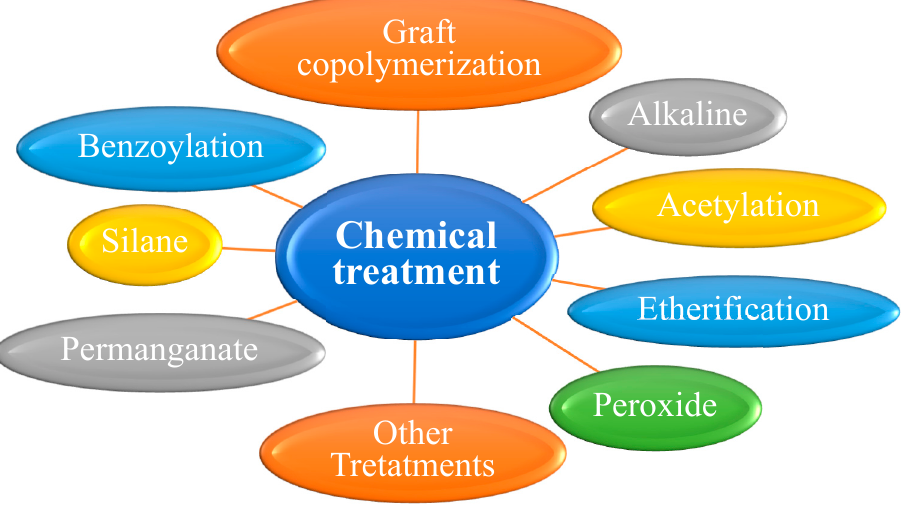
Figure 8. Different types of chemical treatments for natural fiber.